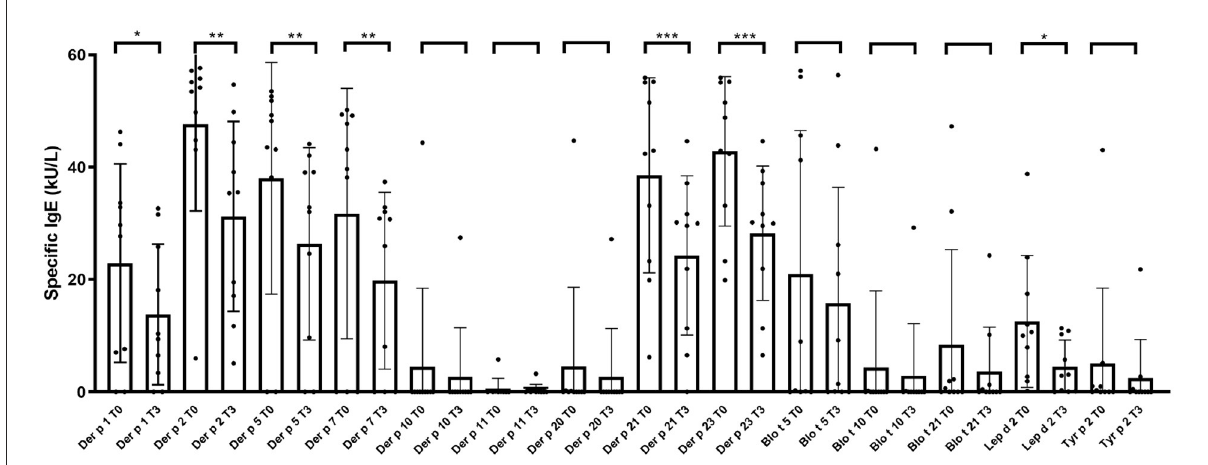
FIGURE1 Evolution of serum specific IgE profiles to 14 allergen molecules from Dermatophagoides pteronyssinus, Blomia tropicalis, Lepidoglyphus destructor, and Tyrophagus putrescentiae in subjects afflicted with severe atopic dermatitis tested with microarray, before (T0) and after treatment with dupilumab 300mg every 2 weeks for 52 weeks (T3). Asterisk indicate statistical significance (* p < 0.05; ** P < 0.01; and *** p <